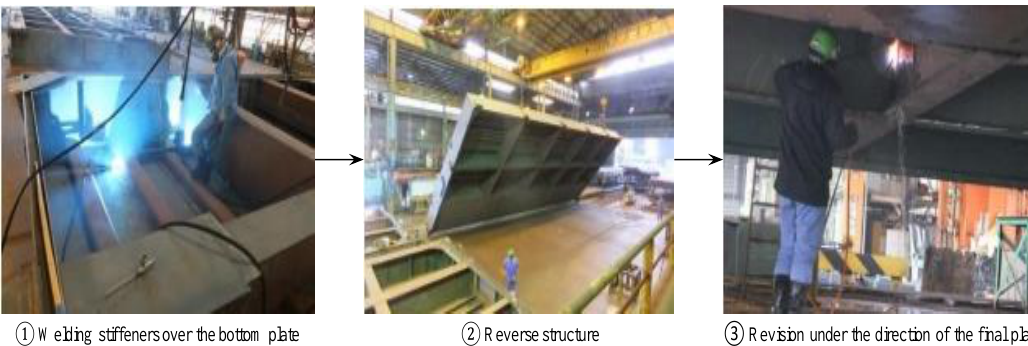
Figure 16. Welding work process of a hatch cover.